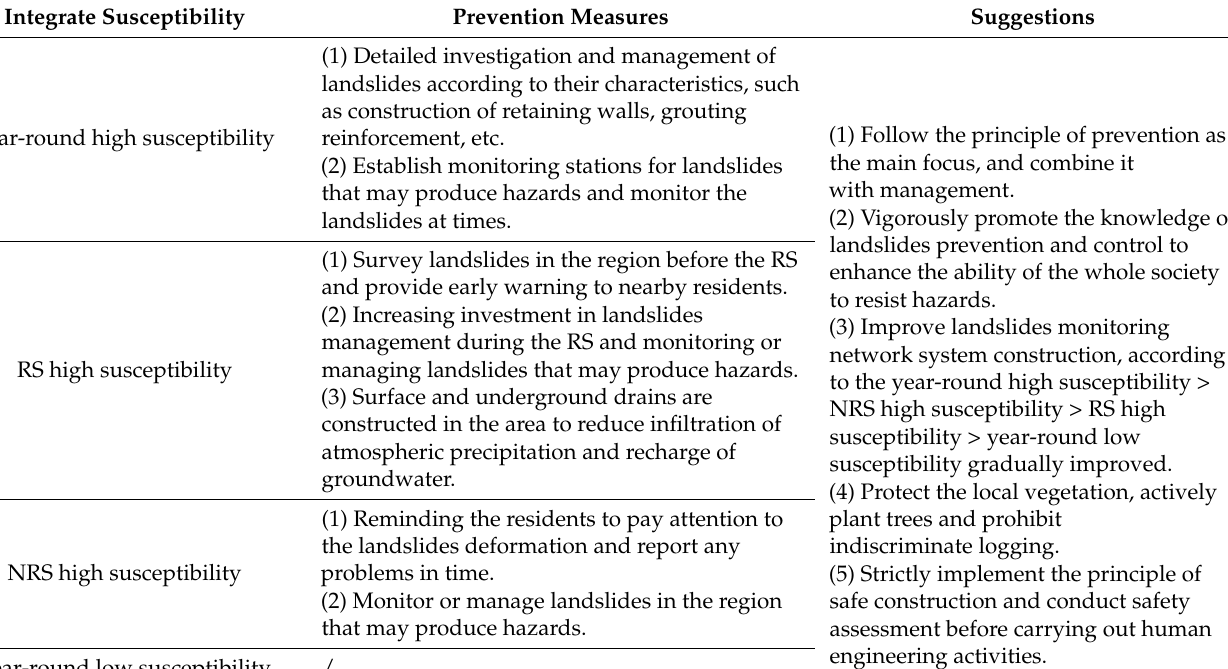
Table 8. Prevention measures and suggestions for the study